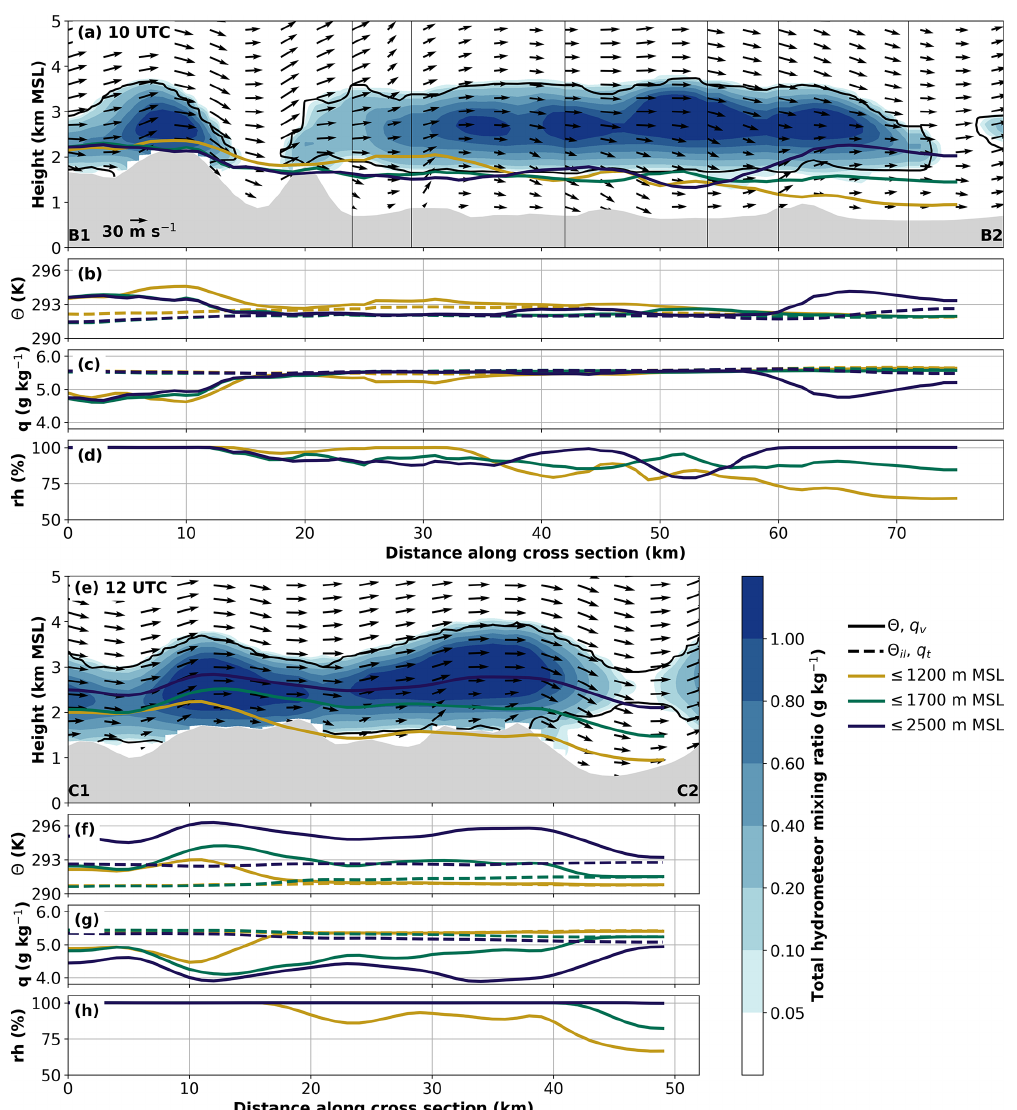
Figure 13. Vertical transect of the wind field and the median trajectory height are as in Fig. 12 for (a) CS_LTA at 10:00UTC and (e) CS_WST at 12:00UTC on 29 October 2017. The black contour line indicates a relative humidity of 99%. Color contours represent the total hydrom- eteor mixing ratio q t – q v . Panels (b) – (d) and (f) – (h) show median trajectory properties for the three arrival heights (same line colors as in Fig. 11). (b, f) θ (solid line) and θ il (dashed line); (c, g) q v (solid line) and q t (dashed line); and (d, h) relative